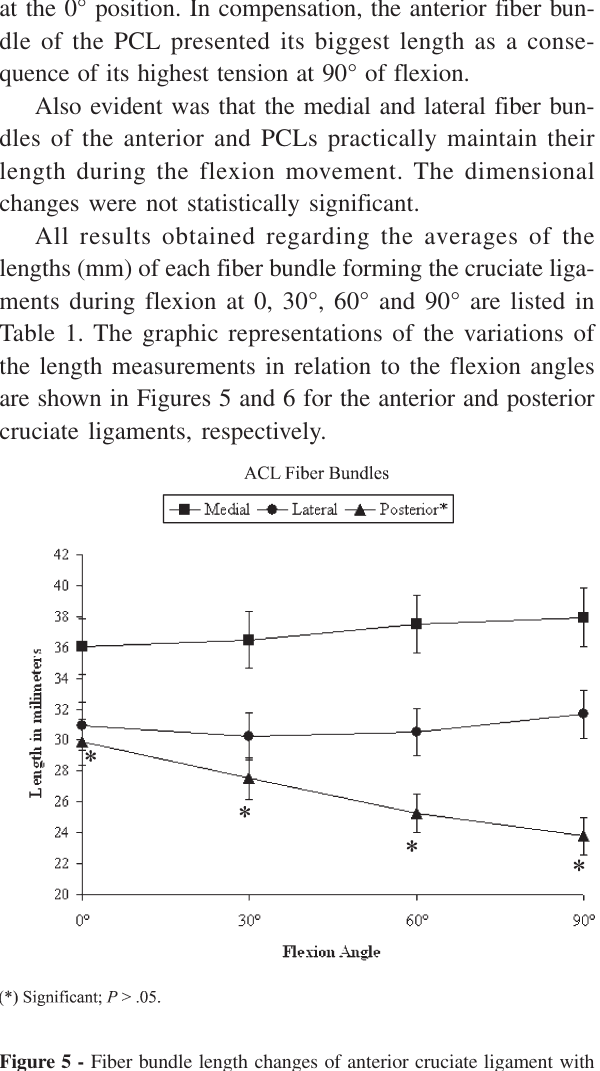
Figure 5 - Fiber bundle length changes of anterior cruciate ligament with flexion angle